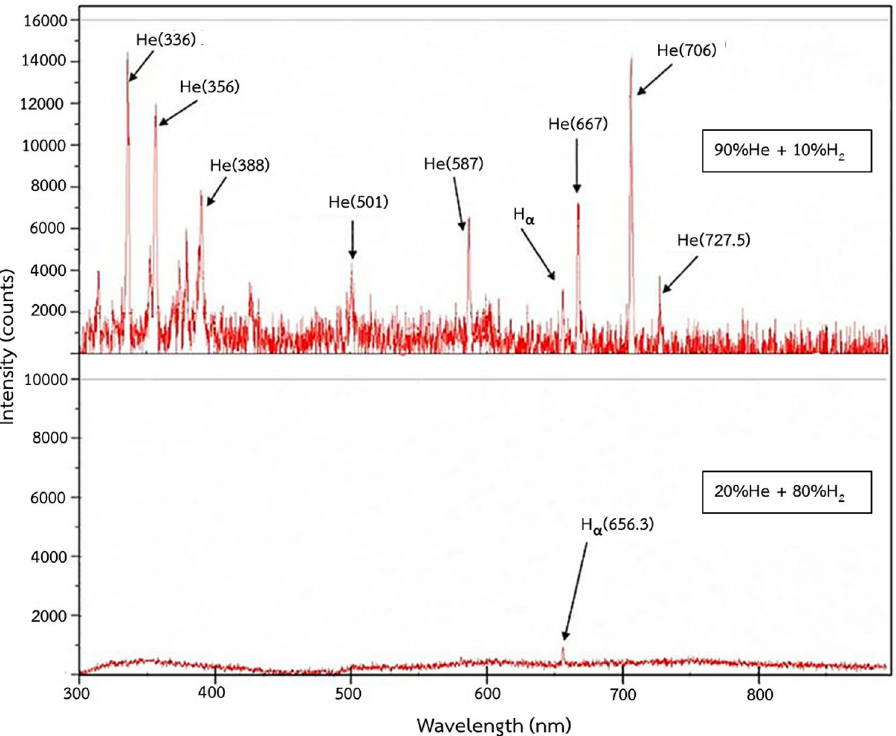
Figure 8. Optical emission spectra of He and H 2 plasma (100 W and 1 mm gap at room temperature).